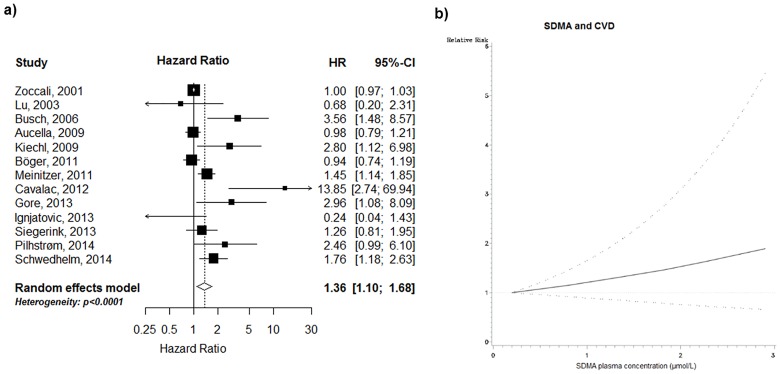
SDMA and CVD: a) high versus low analysis, and b) non-linear dose-response analysis (based on 5 studies, p for non-linearity = 0.059).Black square: point estimate for individual study; horizontal line: 95% CI for observed effect in each study; diamond: pooled estimate and 95% CI for meta-analysis. Random-effects estimate (DerSimonian and Laird method).